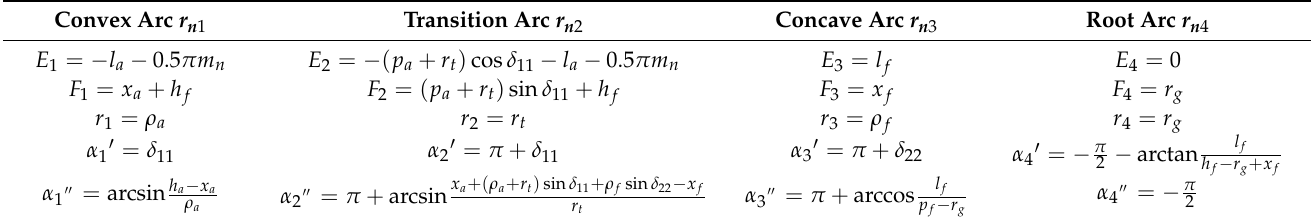
Table 1. Calculation parameters of standard double circular arc tooth profile.